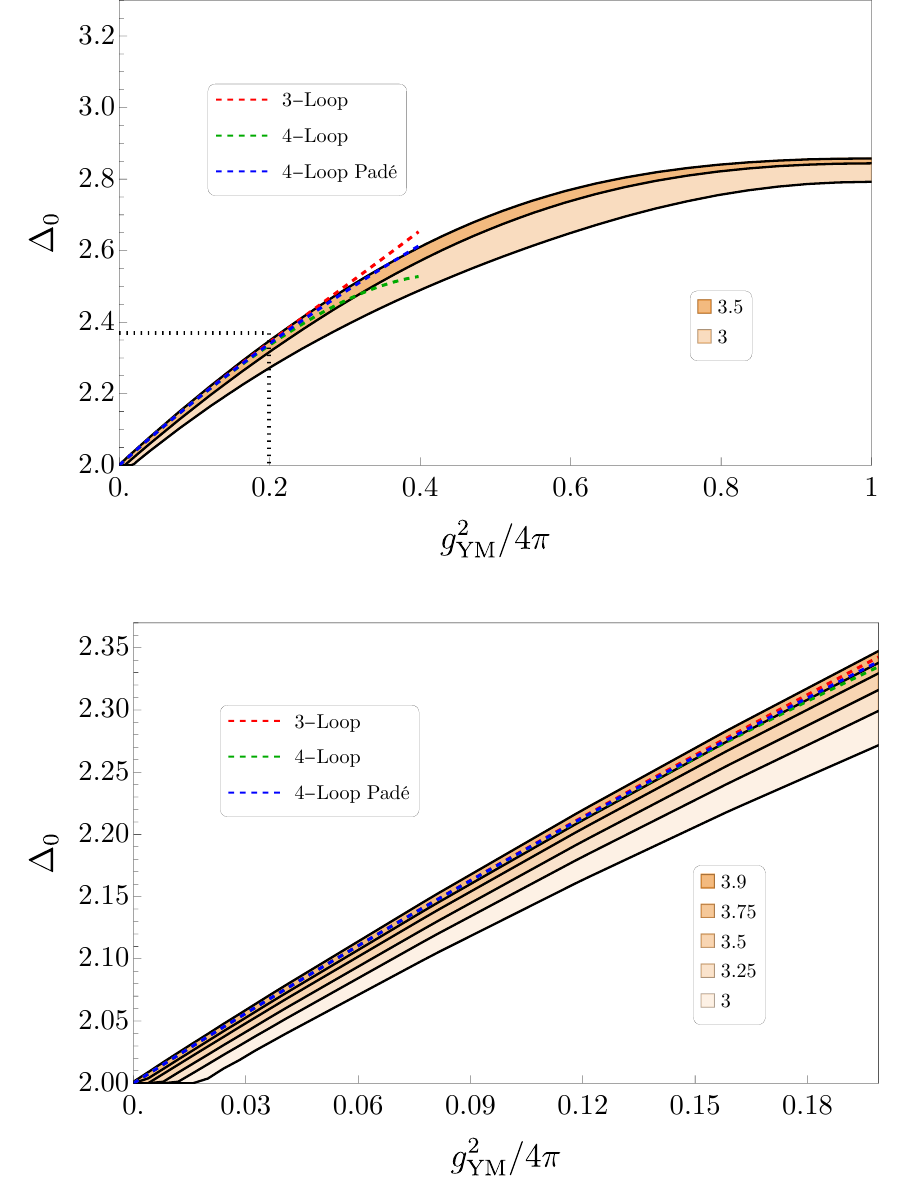
Figure 12 . Lower bounds for the lowest scaling dimension obtained by assuming various gaps below 4, obtained with bootstrap resolution Λ = 39 , for the SU(2) theory at θ = 0 . The upper panel shows two of these lower bounds at θ = 0 as a function of g 2 , and the weak-coupling estimates of ∆ 0 . YM The lower panel shows that the 4-loop Padé approximant is within the bounds obtained with a gap at 3.9 up to g 2 / 4 π ∼ 0 . 2 YM